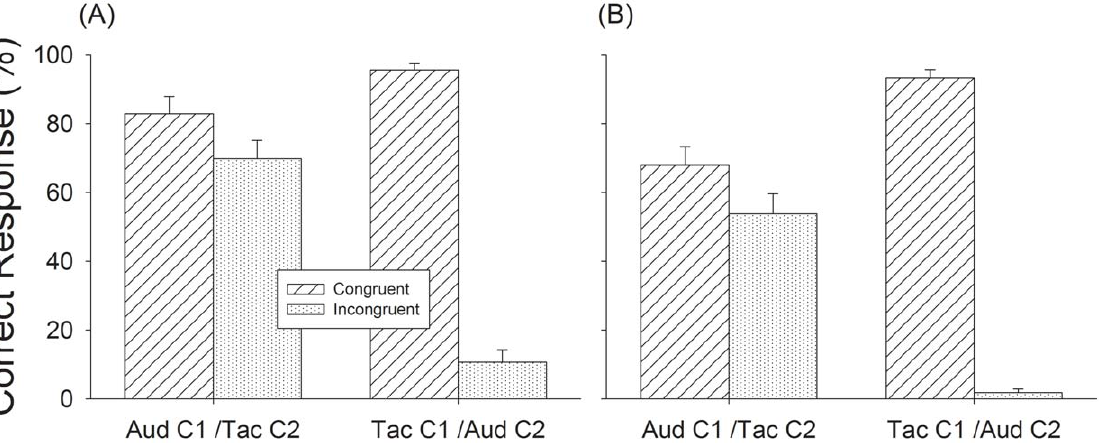
Figure 7. Results of Experiment 4, meter recognition performance in triple sequences (A) and duple sequences (B). Hashed bars show congruent condition and dotted bars show incongruent condition. Error bars are standard error.